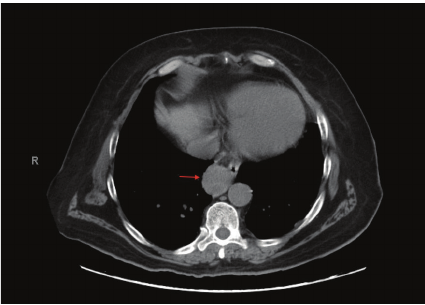
Figure 4: CT scan showing a 3.5 cm azygoesophageal recess mass closely approximating the